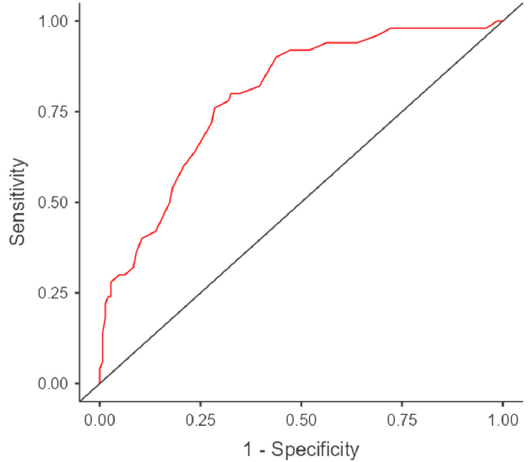
Figure 2. The performance of the test’s final score to predict the status of vaccination.